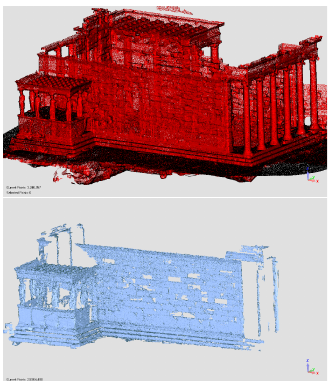
Figure 8: Erechtheion - Top: Laser, Bottom: Photogrammetry